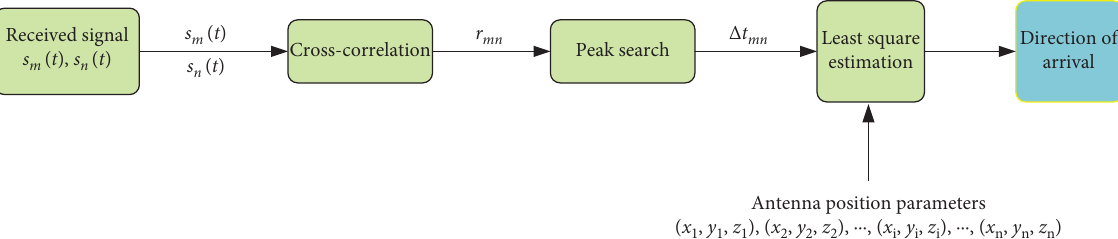
Figure 8: Flow diagram of multiple baseline wideband time-domain interferometry.